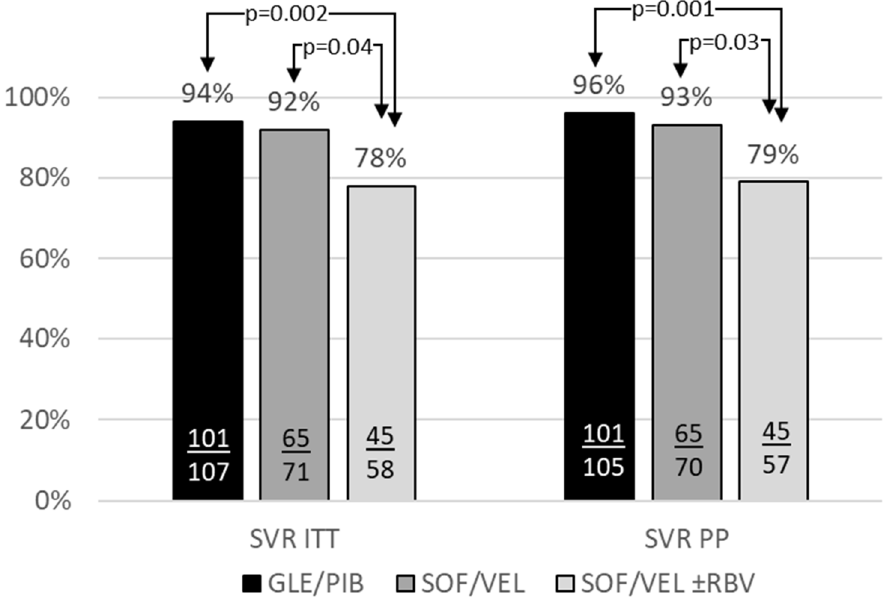
Figure 2. The effectiveness of the GLE/PIB, SOF/VEL, and SOF/VEL + RBV options in GT3 infected patients with liver cirrhosis.